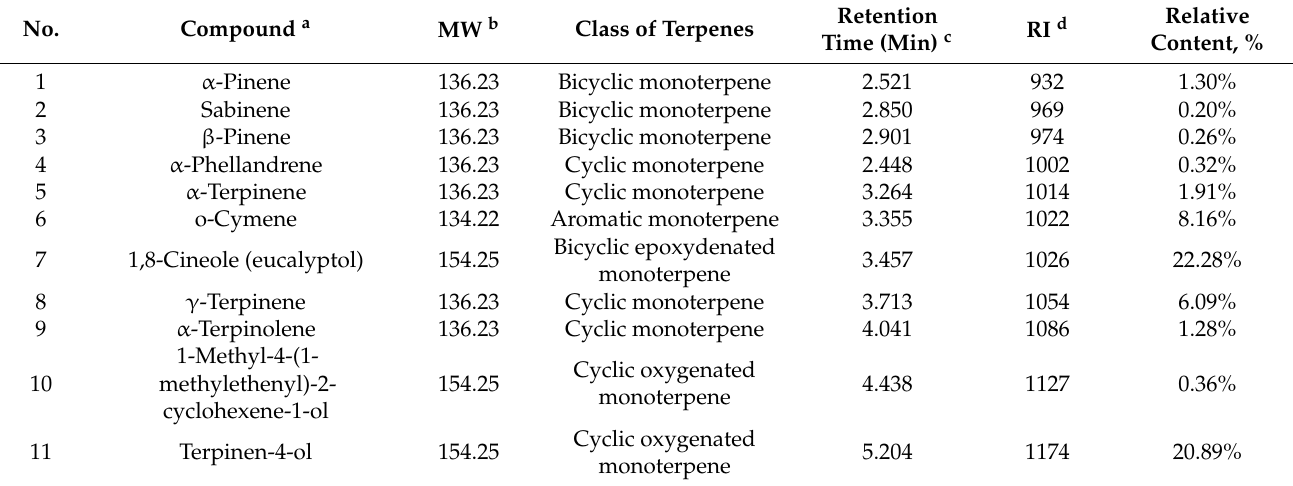
Table 2. The plant-based substance constituents.